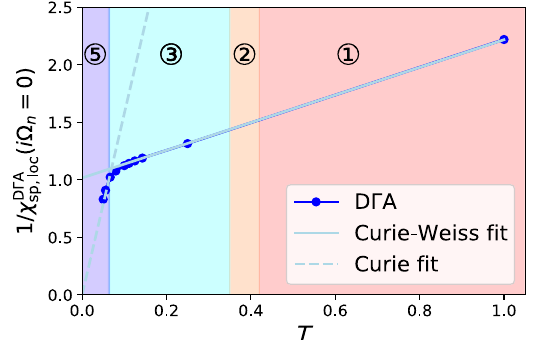
FIG. 27. Inverse local spin susceptibility calculated in D Γ A as a function of temperature, which exhibits Curie-Weiss (Curie) behavior in the metallic (insulating) regime.